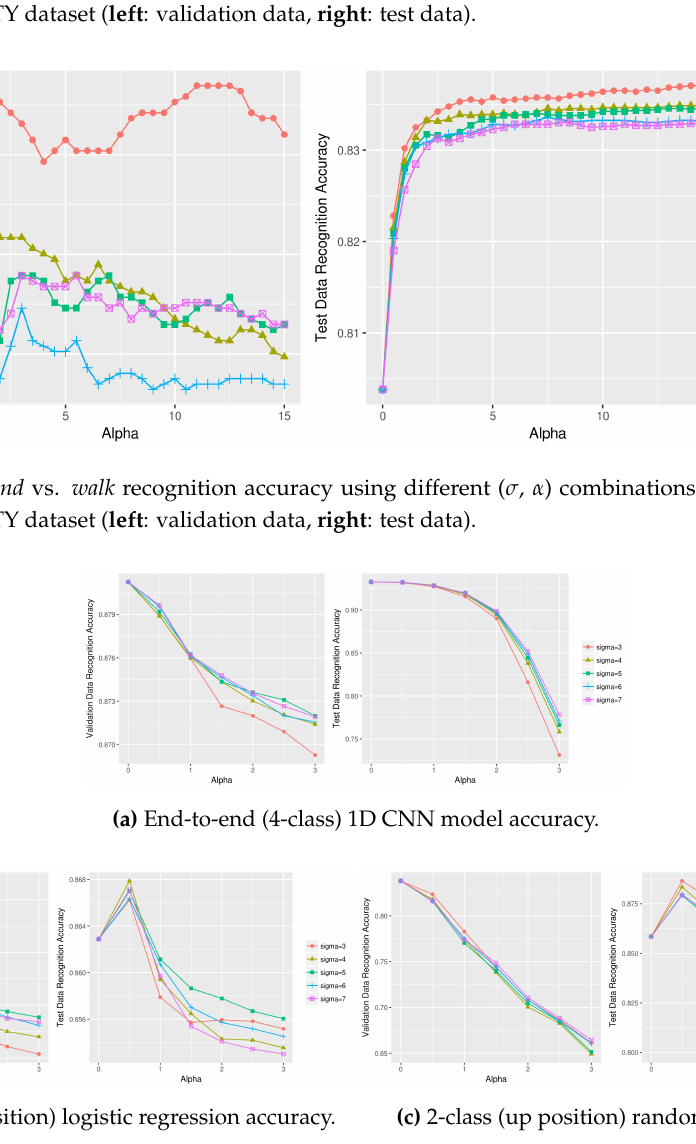
Figure 14. Unsuccessful test data sharpening cases using lower body data (left: validation, right: